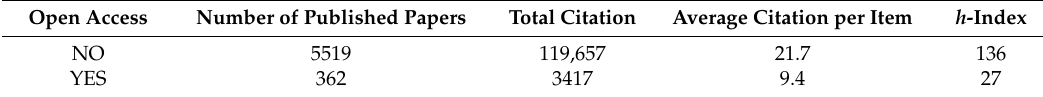
Table 5. Number of H 2 SBM papers published in non-open access and open access journals. Open